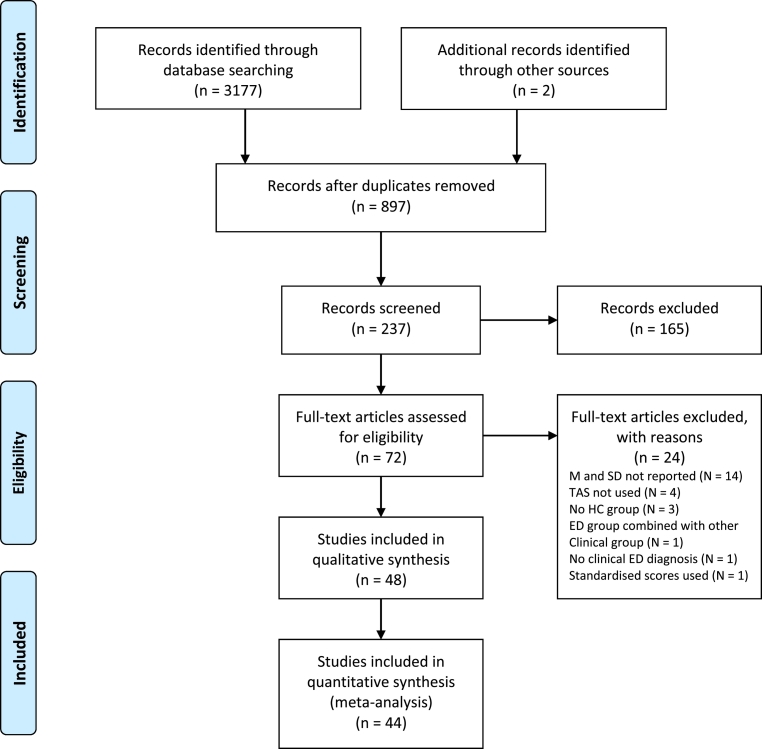
Systematic review search process.